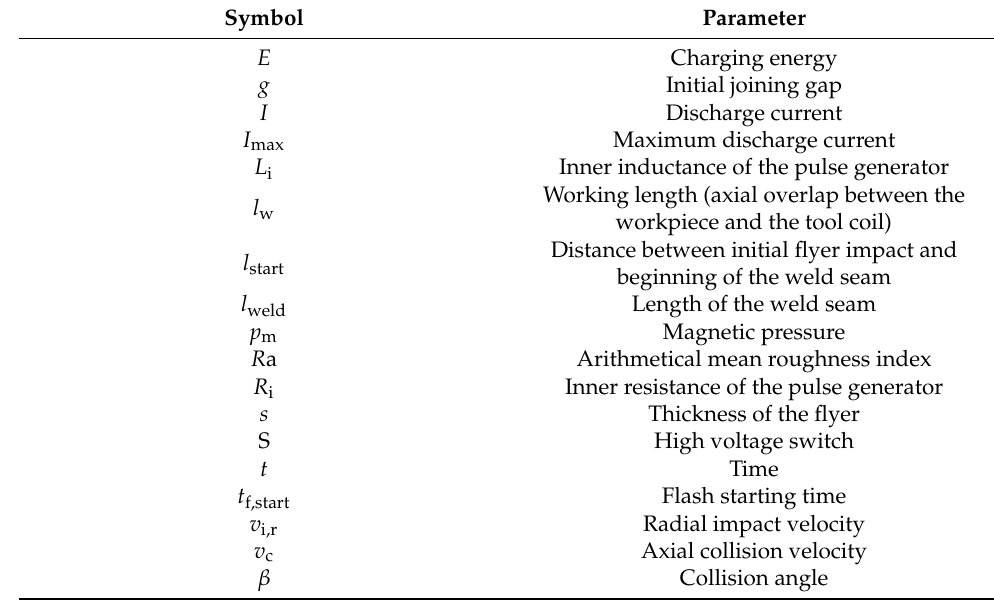
Table 1. Nomenclature for experimental setup and sample